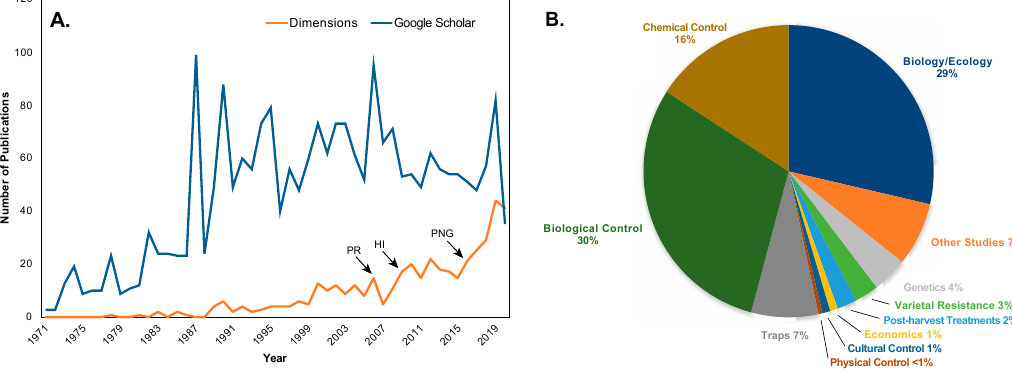
Figure 2. World distribution of the co ff ee berry borer (CBB). Countries with CBB prior to 2007 are highlighted in green. Island regions that were recently invaded are highlighted in red from left to right; Hawaii (2010), Puerto Rico (2007), and Papua New Guinea (2018). The only countries without CBB (Nepal, China, and Australia) are highlighted in blue.